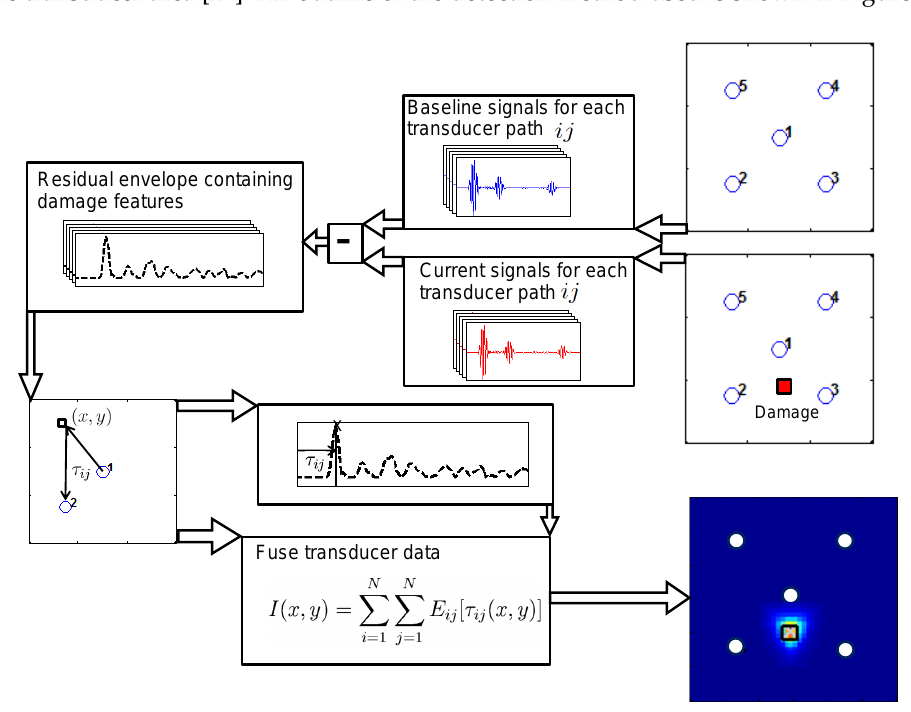
Figure 9. Main steps in the delay-and-sum method for damage localisation